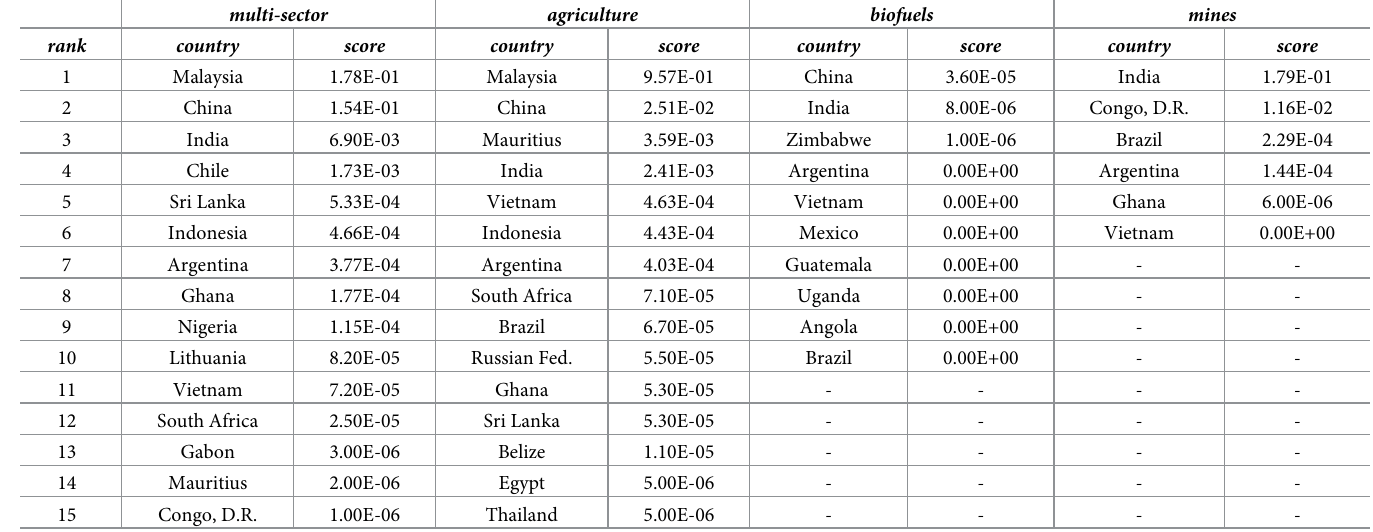
Table 3. Top-ranked countries and their ranking scores obtained by LurkerRank in the multi-sector , agriculture , biofuels and mines networks. Sink (i.e., pure inves- tors) and source (i.e., pure target) nodes are excluded from the ranking, in compliance with the fact that only double role countries are regarded as potential anomalies.